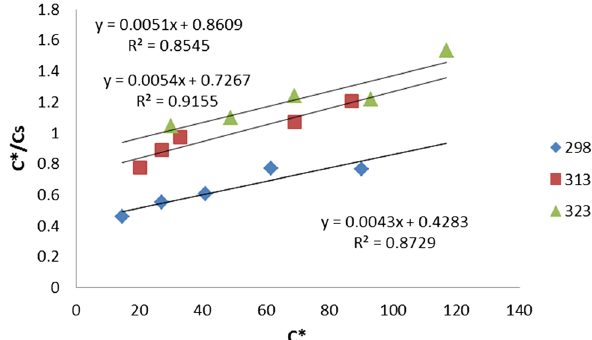
Fig. 6 Langmuir isotherm plots for biosorption of Cd(II) onto N. oculata biomass (biomass dosage 20 g/L; contact time 60 min; pH 5; temperature 298